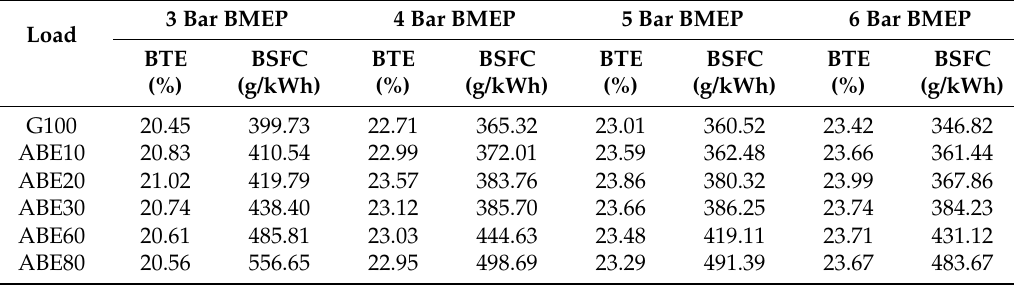
Table 7. BTE and BSFC of test fuels at different engine loads.